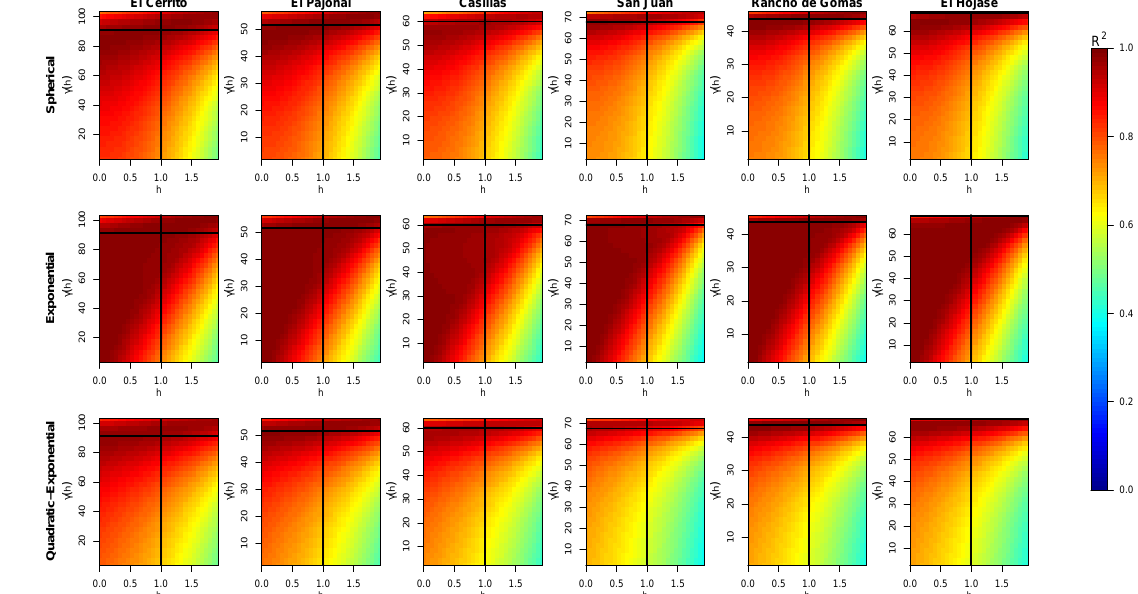
Figure 7. Obtained values of R 2 (color bar) for different pair of data ( r 0 , γ ( r 0 )) when fitting a curve for the variogram of each station with the three models and considering the nugget effect. The intersection of the black solid lines tags the real R 0